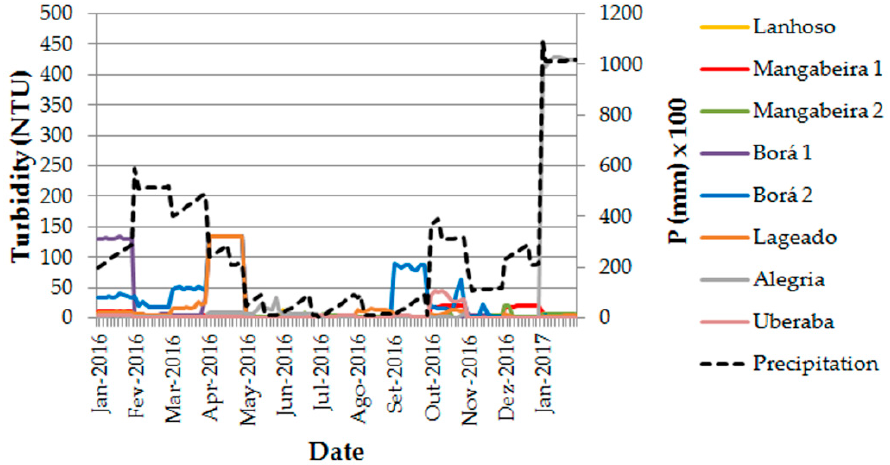
Figure 8. Values of daily precipitation and stream water turbidity observed in the studied catchments during the sampling campaigns. The discrete values are provided as Supplementary Material.